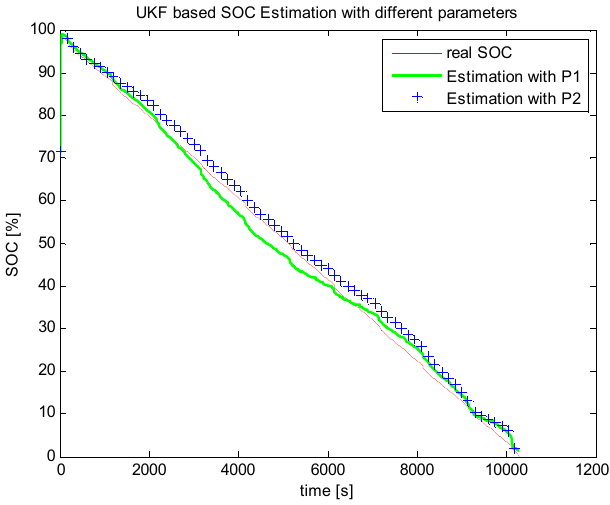
Figure 4. Influence of model parameters for UKF-based SOC estimation. The conditions for the two experiments are the